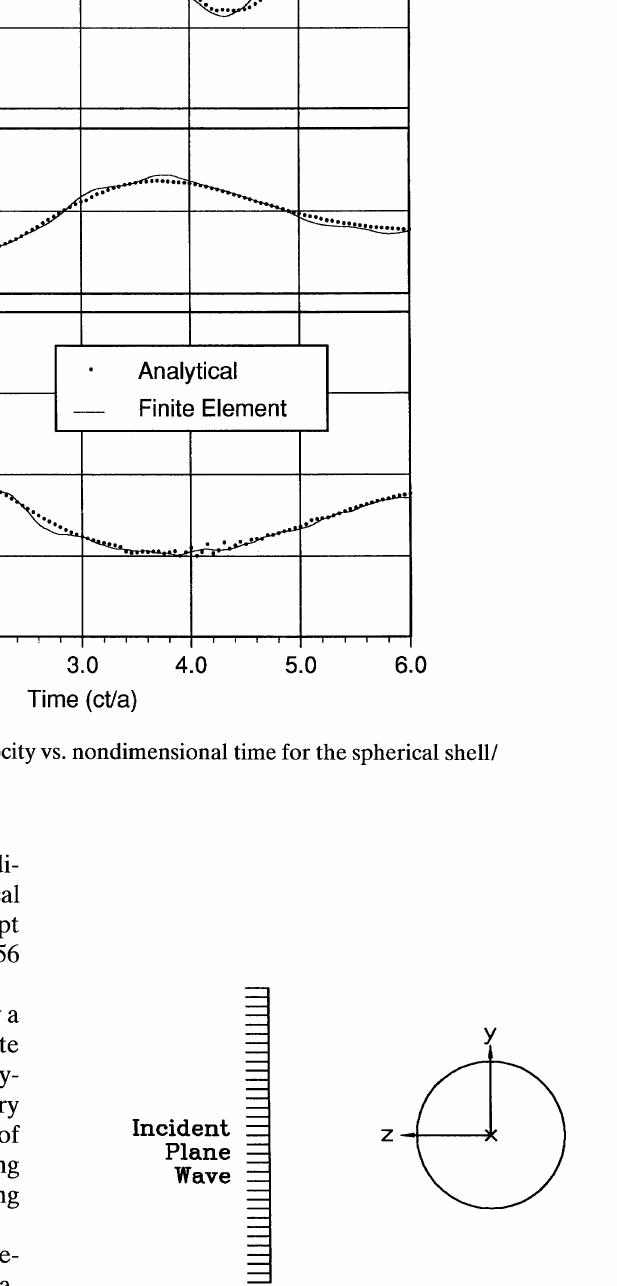
FIGURE 7 Infinite cylinder subjected to plane step wave problem